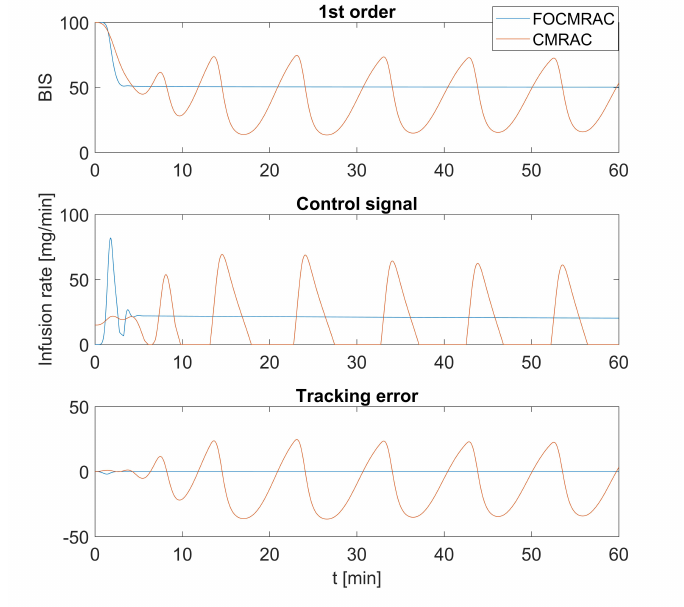
Figure 26. Comparison between the 1st-order FOCMRAC and the closed-loop model reference adaptive control (CMRAC), BIS output, control signal, and tracking